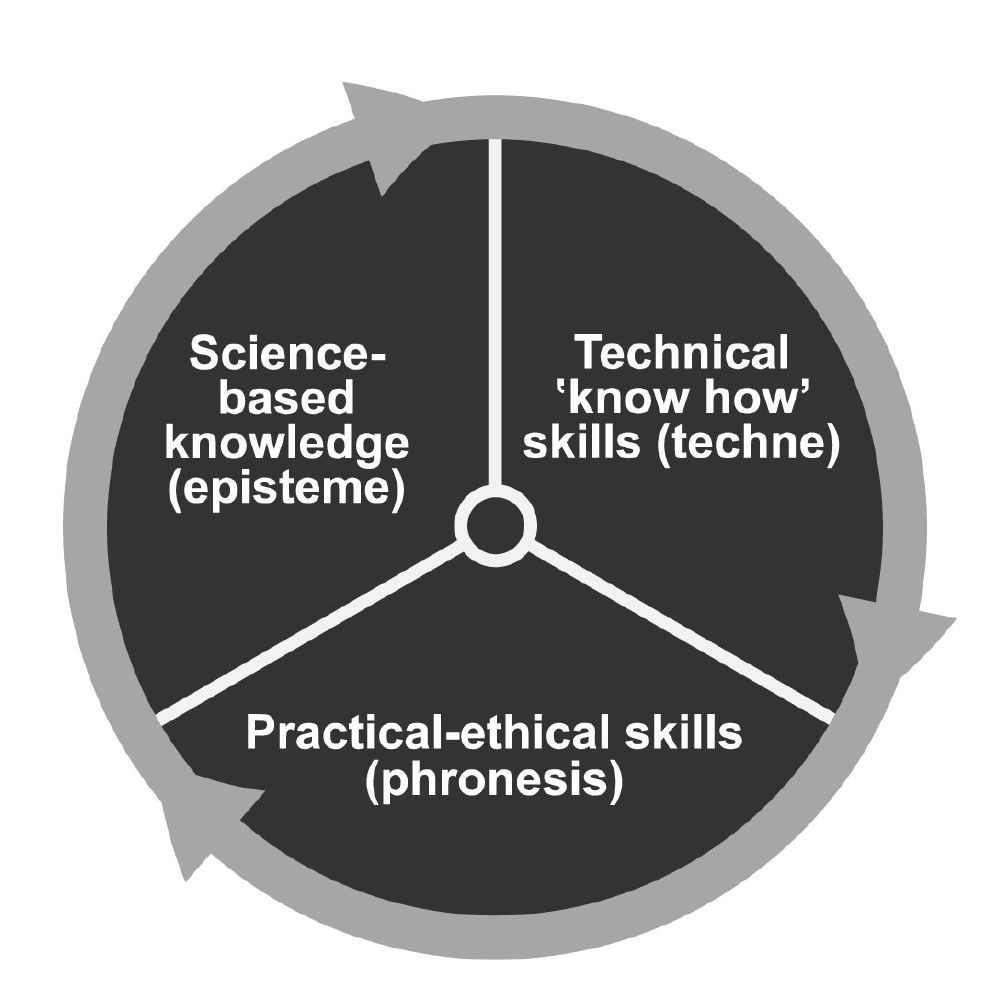
Figure 2 : Professional knowledge: The trisection of science-based knowledge, technical knowledge - ‘know how’ (practical skills) and practical-moral knowledge corresponds to the Aristotelian divide between episteme, techne and phronesis (Aristotle, 2013; Gilje, 2017). As argued by Gilje (2017), building on the work of Grimen (2008), different kinds